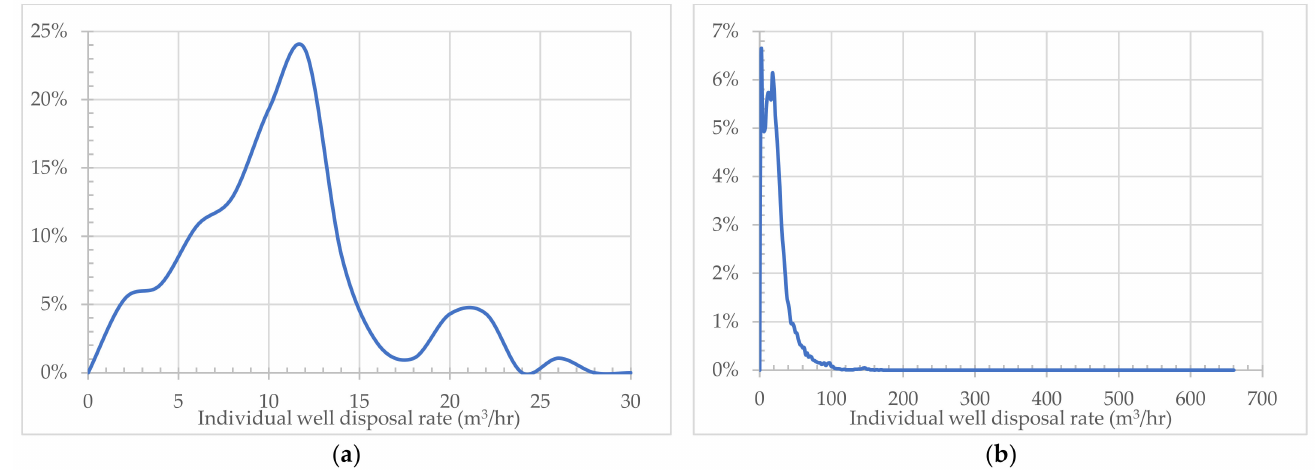
Figure A16. Historical per-well water injection rate ( X -axis) frequency ( Y -axis) distributions (January 1962–December 2022) in ( a ) the Nikanassin Formation; ( b ) the Sawtooth Formation.